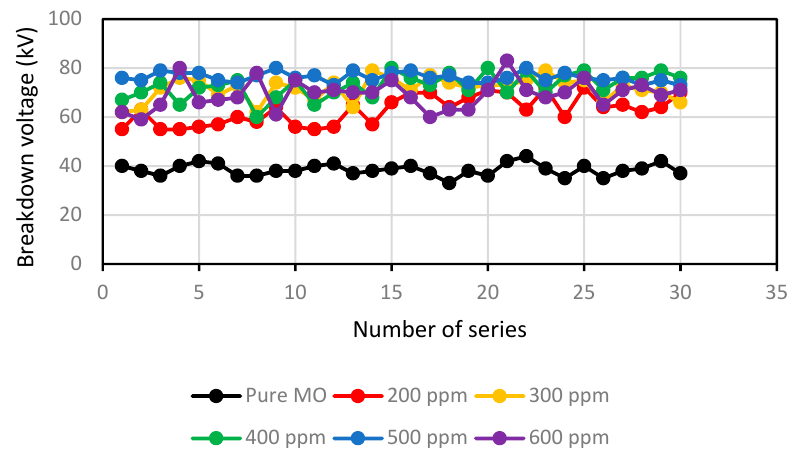
Figure 3. The breakdown voltage for various concentrations of the MO/CH 3 I scavenger.